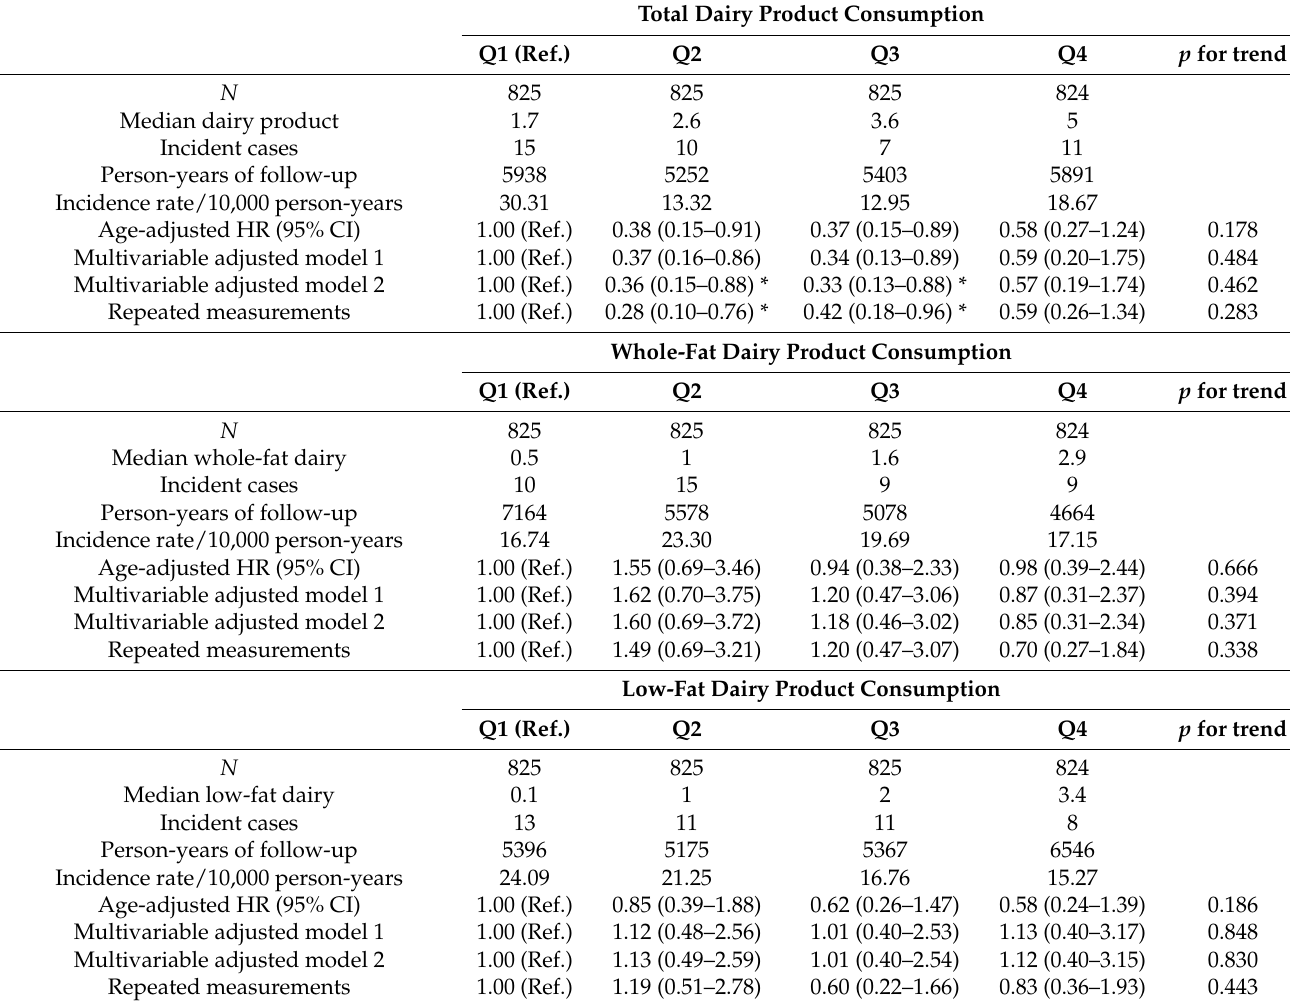
Table 4. Hazard ratio (HR) and 95% confidence intervals (CI) of confirmed postmenopausal breast cancer cases according to the categories of baseline total dairy, whole-fat, low-fat, and fermented dairy product consumption among 3299 women of the SUN